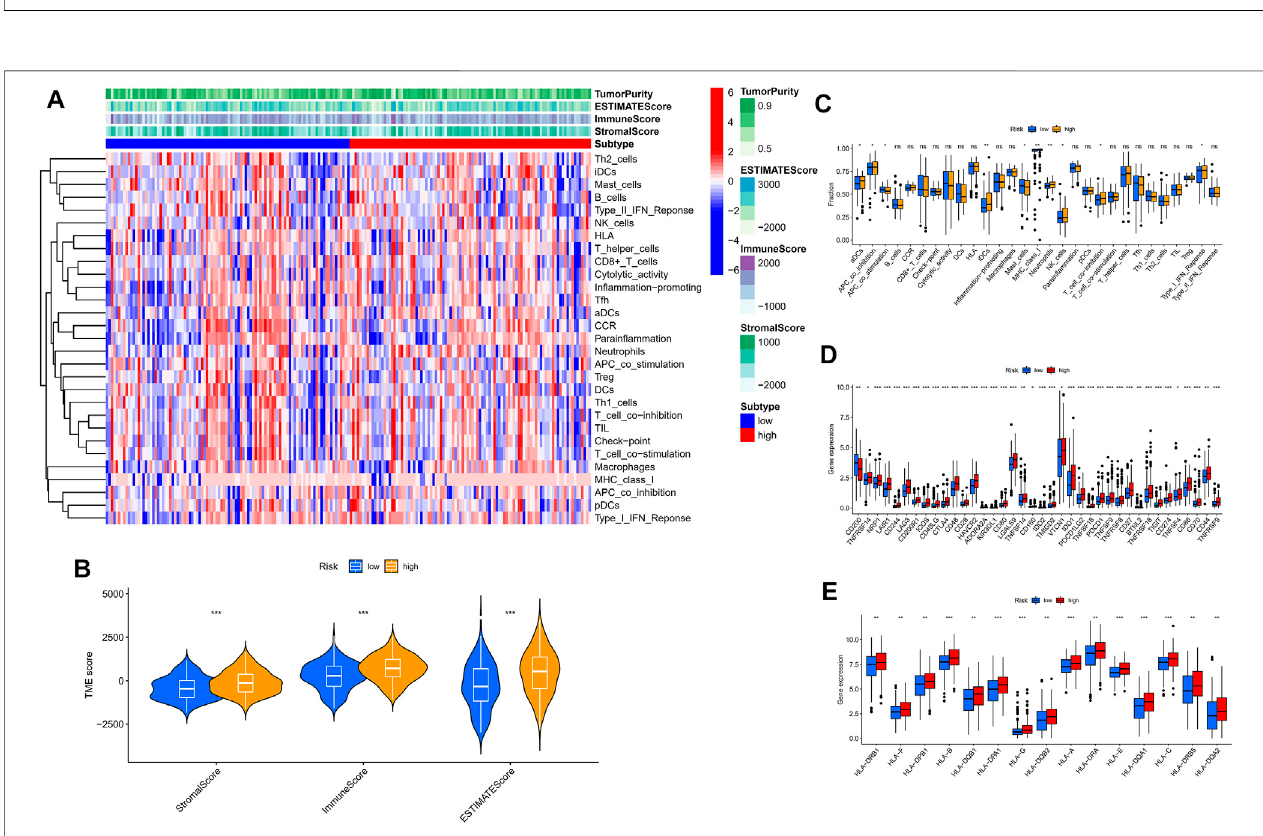
FIGURE 7 | The low- and high-risk groups display different immune statuses. (A) Heatmap of the distribution of 29 immune cells between the low- and high-risk groups using ssGSEA. (B) Expression level of estimate score, immune score, and stromal score between the low- and high-risk groups. (C) Distinction of enrichmentof immune-related signatures between low- and high-risk groups. (D) Comparison of 38 immune checkpoint blockade-related genes expression levels in two risk score subgroups. (E) Comparison of 15 HLA-related genes expression levels in two risk score subgroups. * p < 0.05, ** p < 0.01, *** p < 0.001.